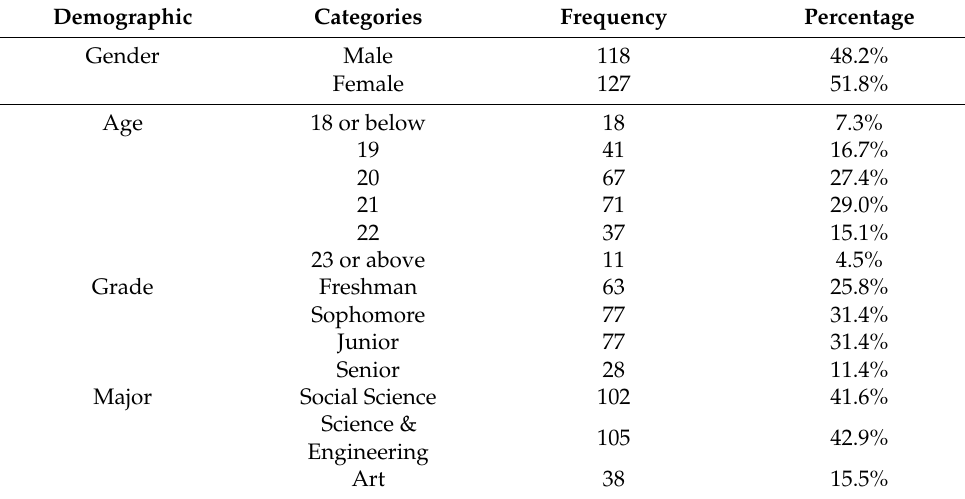
Table 1. Demographic information of the participants.